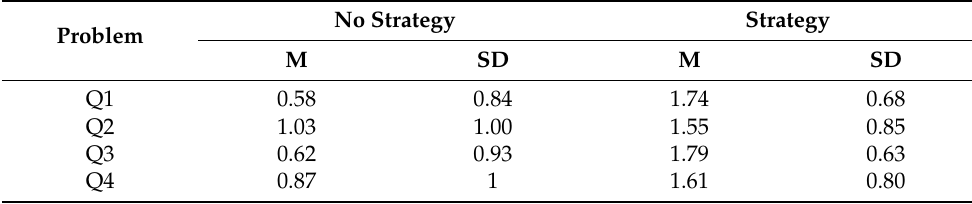
Table 12. Mean and deviation, according to the group and